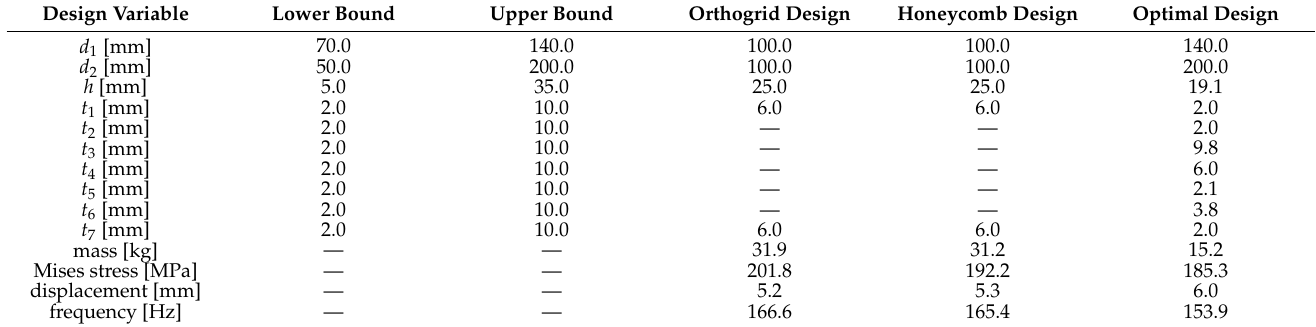
Table 2. The upper and lower bounds of parameters and their optimal result.